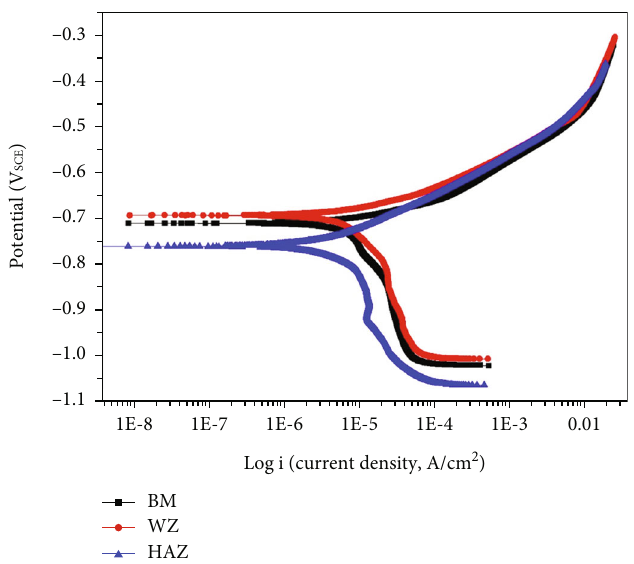
Figure 10: Polarization curves of welded joints in di ff erent